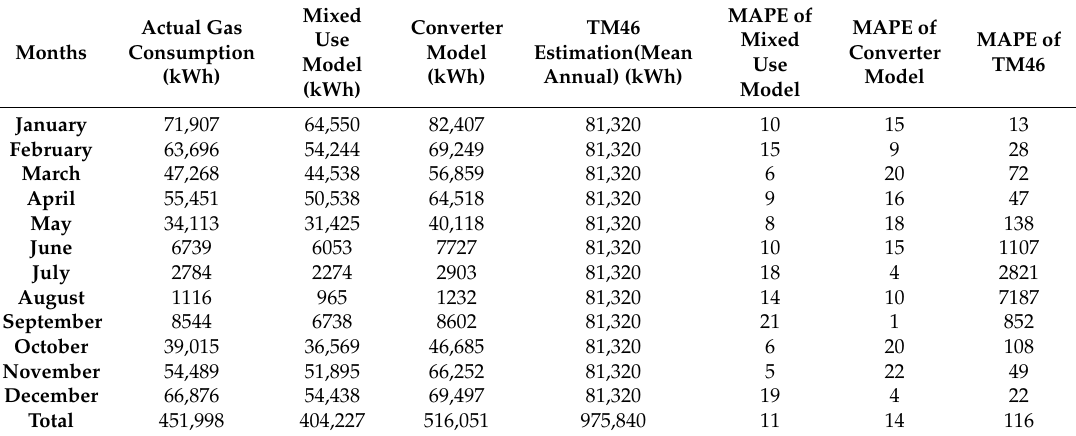
Table 6. Recorded data and monthly profiles and percent of errors compared with mean annual of CIBSE for the Nova Building, UCD.